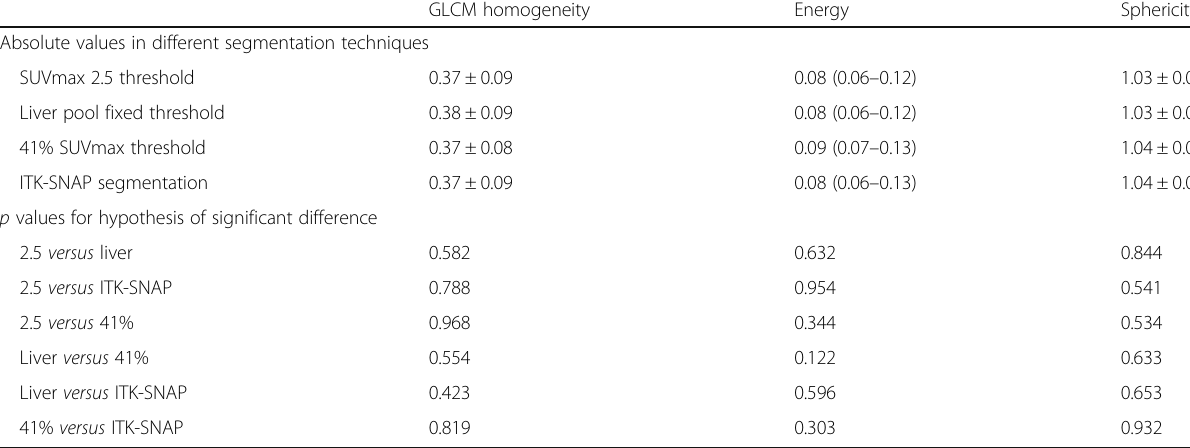
Table 1 Stable radiomic parameters, independent from segmentation technique